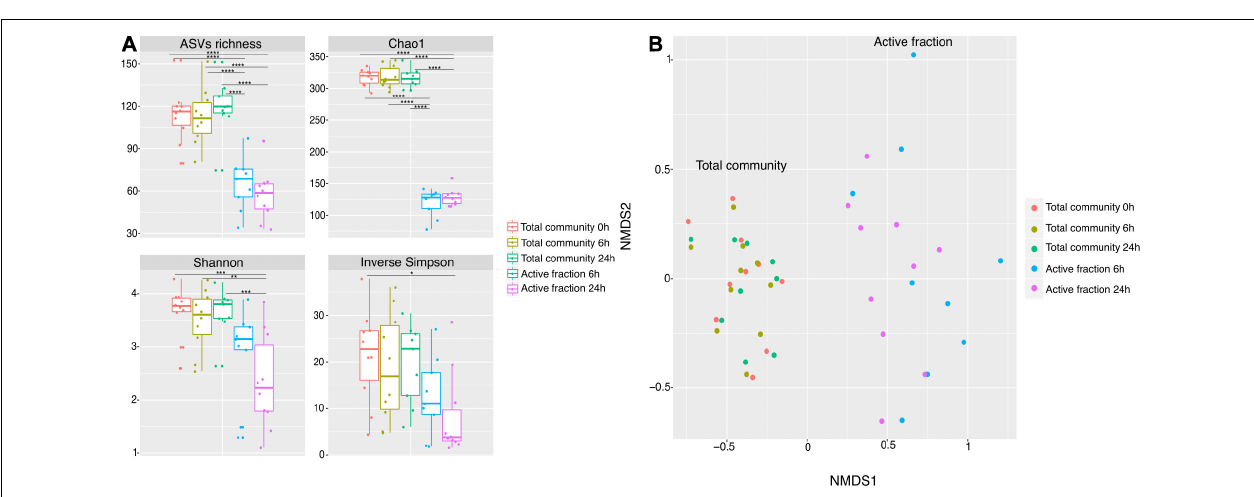
FIGURE 4 | Microbiota richness and diversity in metabolically-active community in rutin incubations. (A) Observed ASVs, Chao1 estimated richness, Shannon diversity, and inverse Simpson diversity estimators show significant difference between time points, active fraction and total community [ASVs richness, Chao1 and Shannon (ANOVA: p < 0.0001, n = 50), Inv. Simpson (ANOVA: p = 0.020, n = 50)]. Multiple comparisons are represented in the figure as asterisks. (B) NMDS ordination shows samples separation between the total community and the active